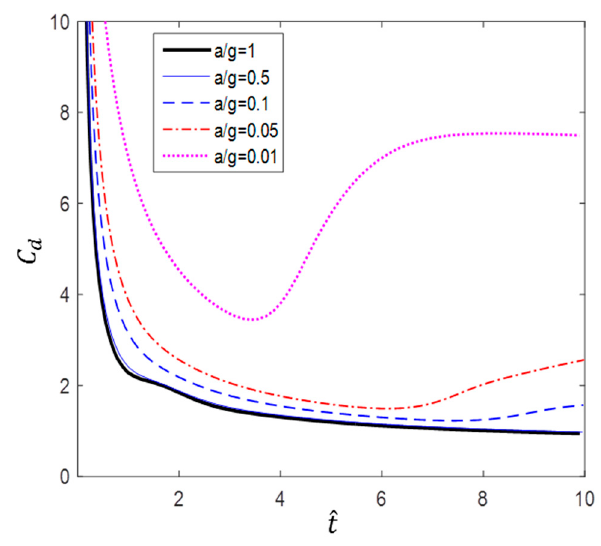
Figure 11. Dimensionless time variation of drag coe ffi cient C d ( Re 0 = 40).